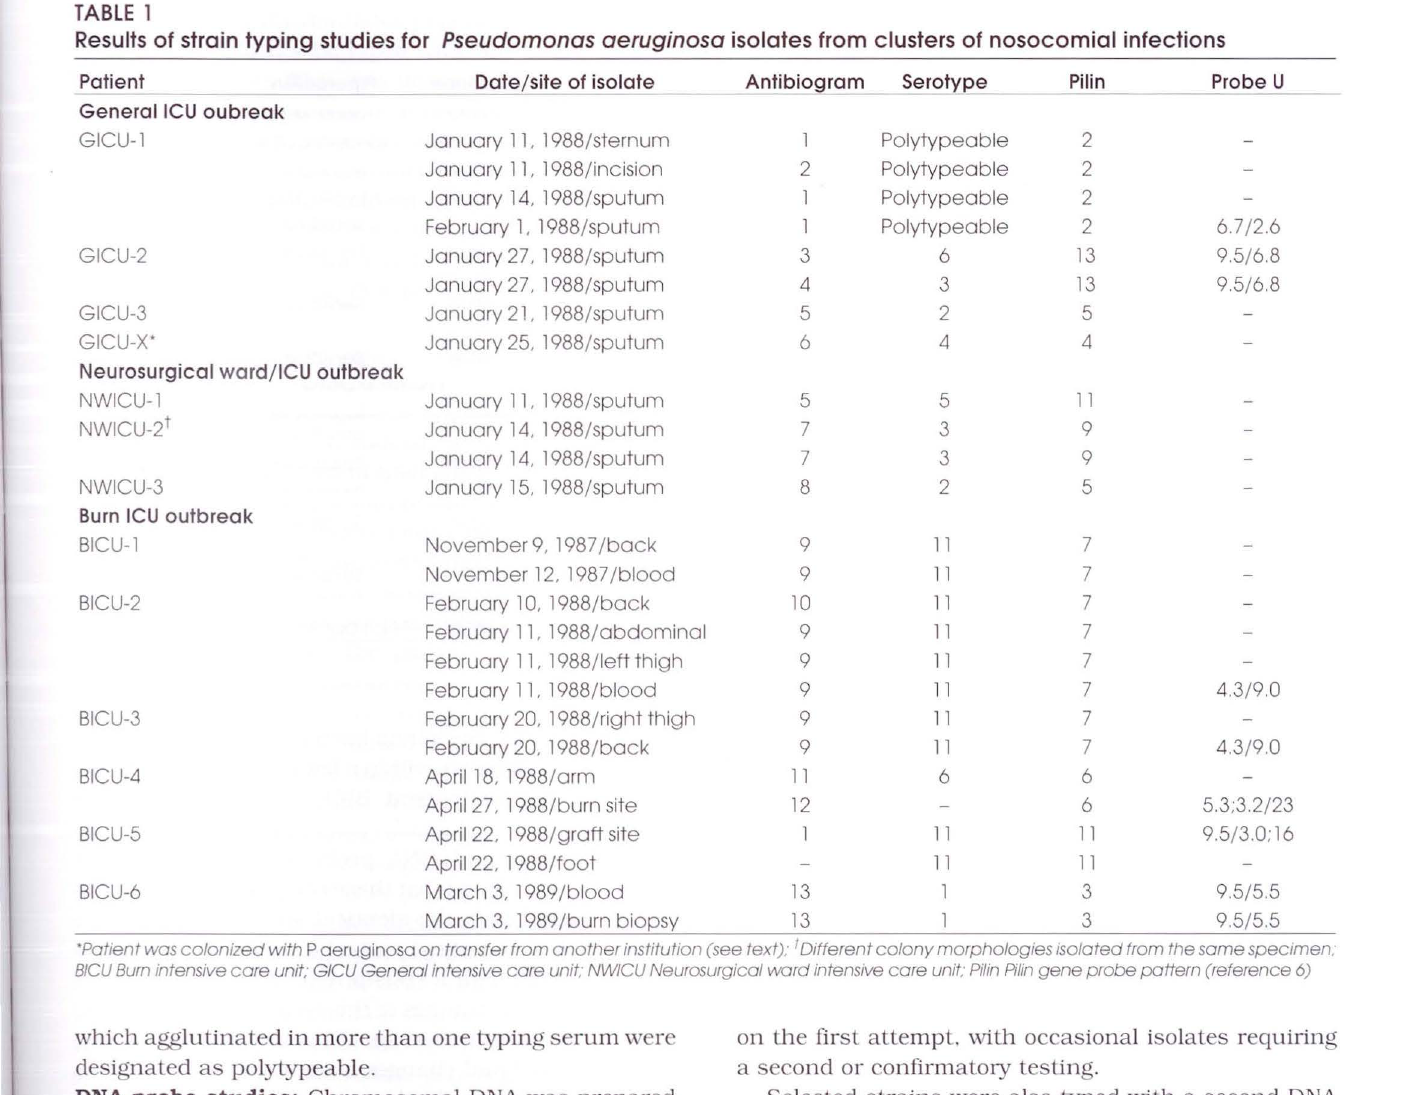
Results of strain typing studies for Pseudomonas aeruginosa isolates from clusters of nosocomial